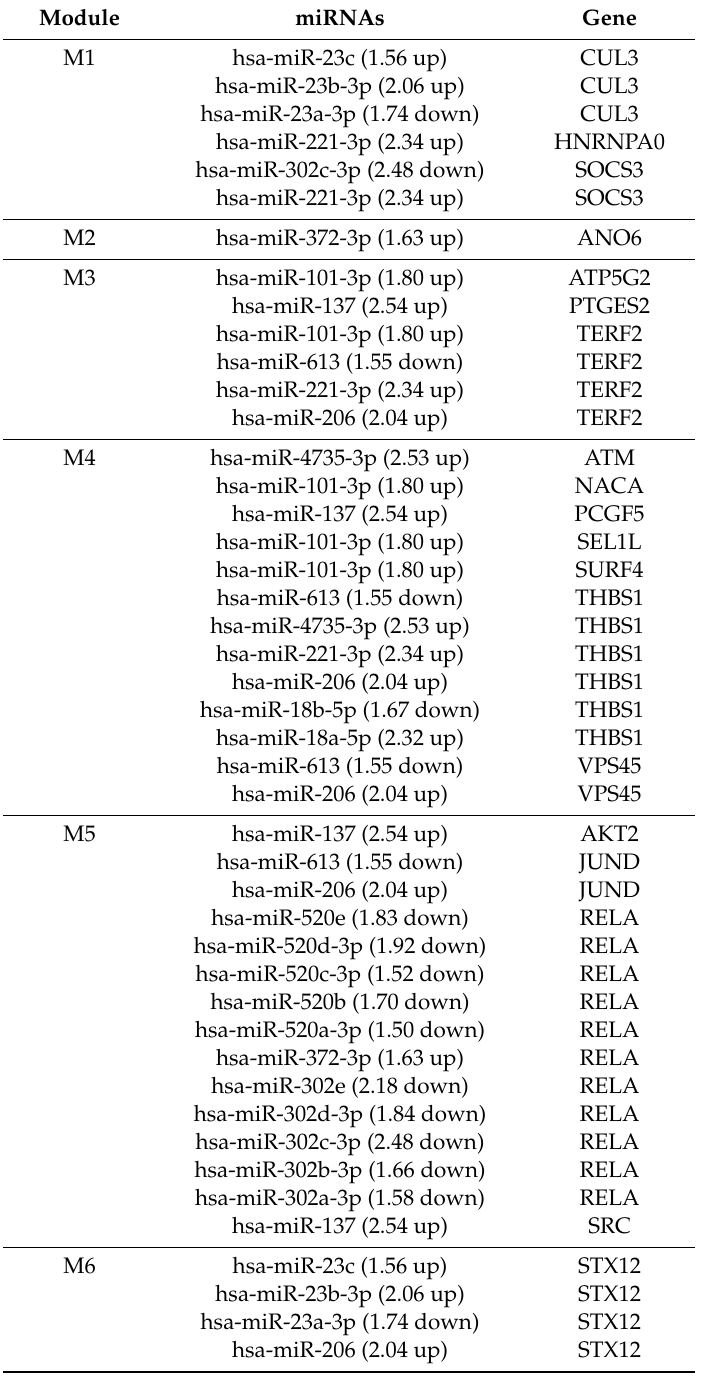
Table 6. Modulated genes included in the six modules that are targeted by